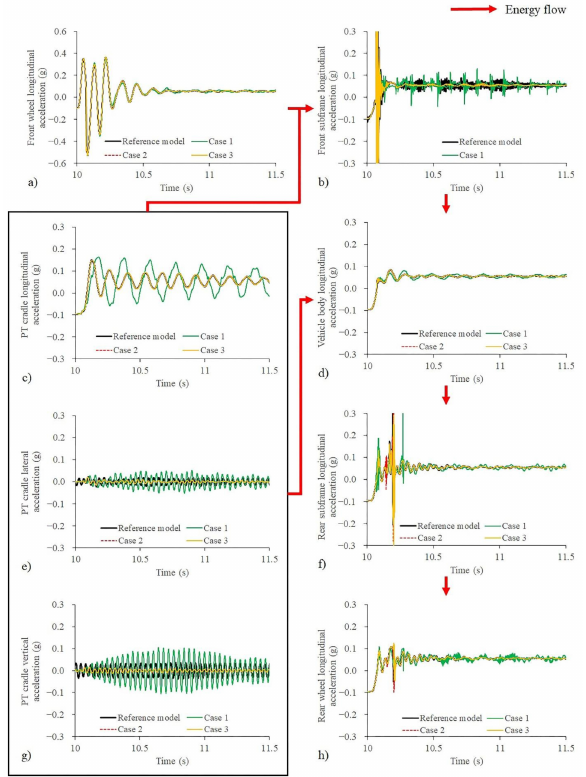
Figure 12. Tip-in event components accelerations EPA on the tarmac and decoupled PT cradle rubber mount properties: ( a ) front wheel longitudinal; ( b ) front subframe longitudinal; ( c ) PT cradle longitudinal; ( d ) vehicle body longitudinal; ( e ) PT cradle lateral; ( f ) rear subframe longitudinal; ( g ) PT cradle vertical acceleration; ( h ) rear wheel longitudinal.